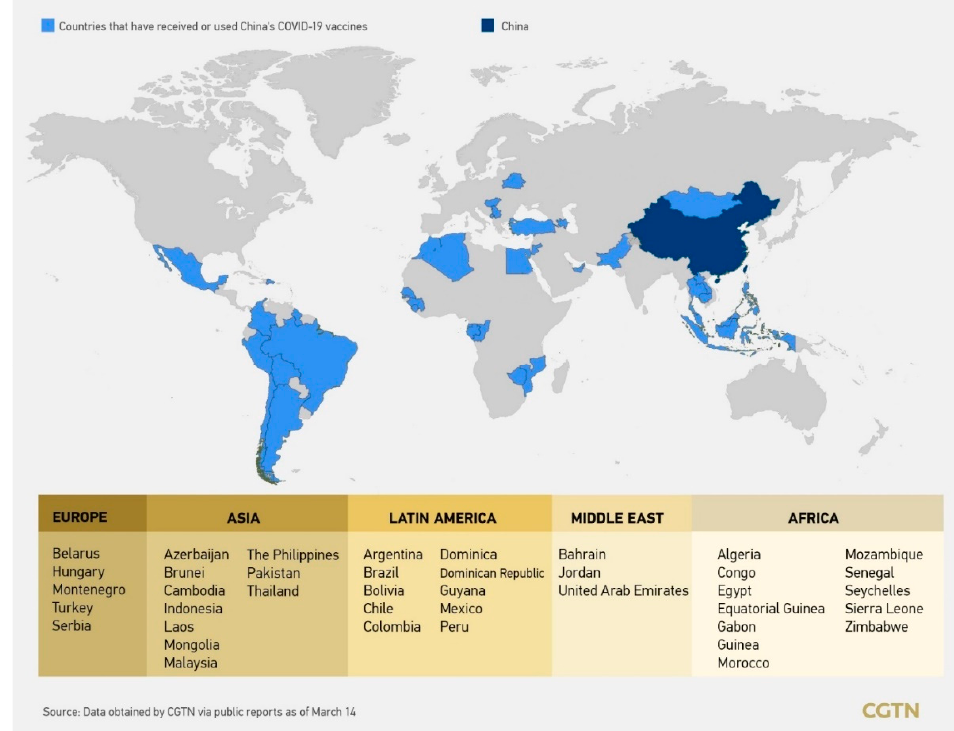
Figure 4. Countries that have received or used China’s COVID-19 vaccines by 14 March 2021 [126] .